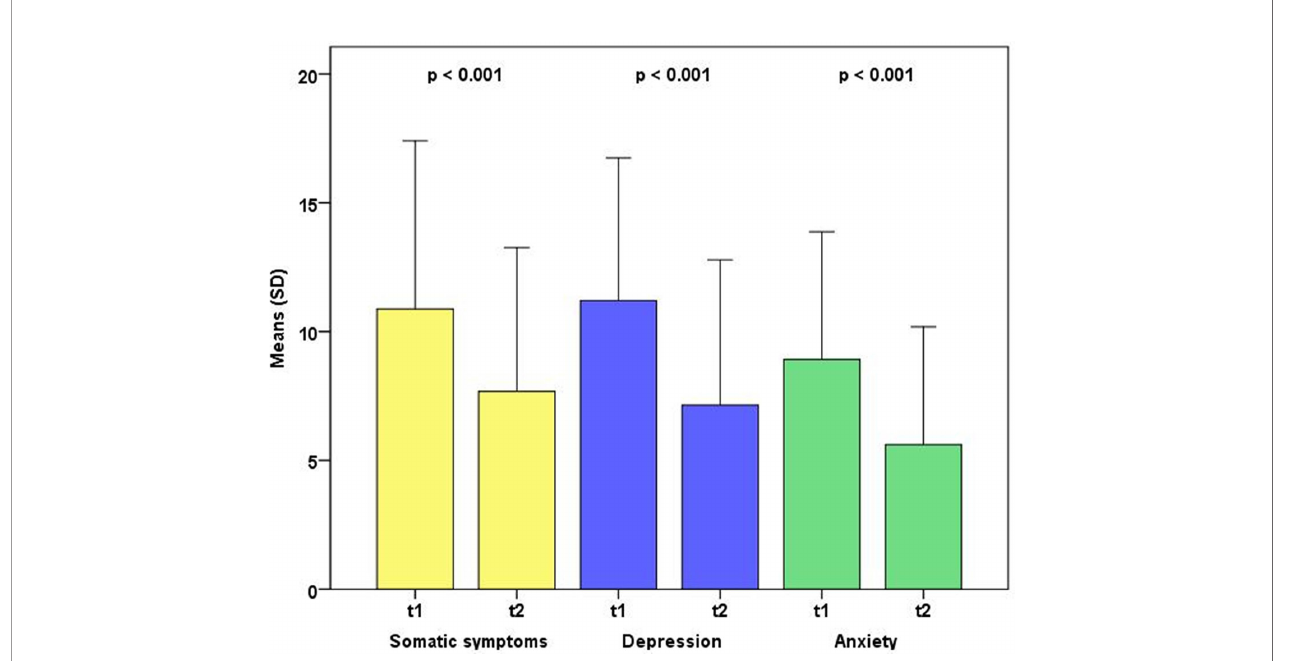
FIGURE 1 | Changes in somatic, depressive, and anxiety symptoms from baseline to follow-up (n = 62 –